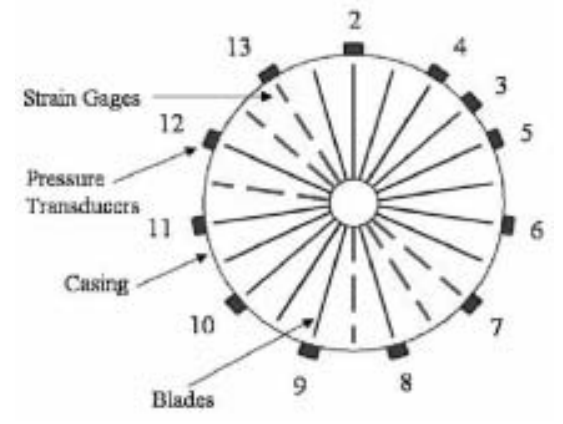
Fig. 3. Schematic diagram of pressure transducer and strain gage locations for the test